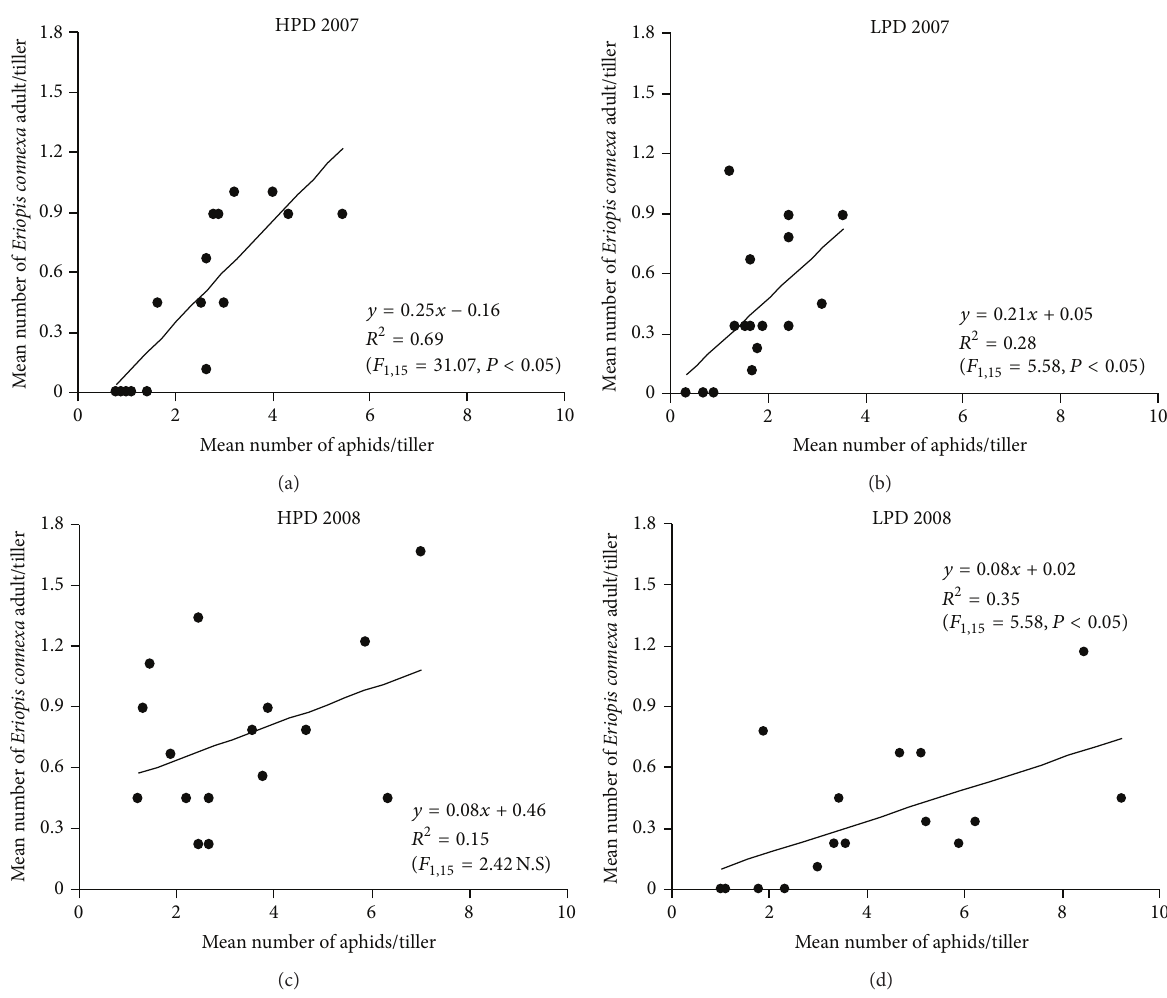
Figure 4: Aggregative numerical response of Eriopis connexa adults to variation in cereal aphid abundance in wheat crops with a high (HPD) and low plant diversity (LPD). Balcarce, 2007 and 2008.